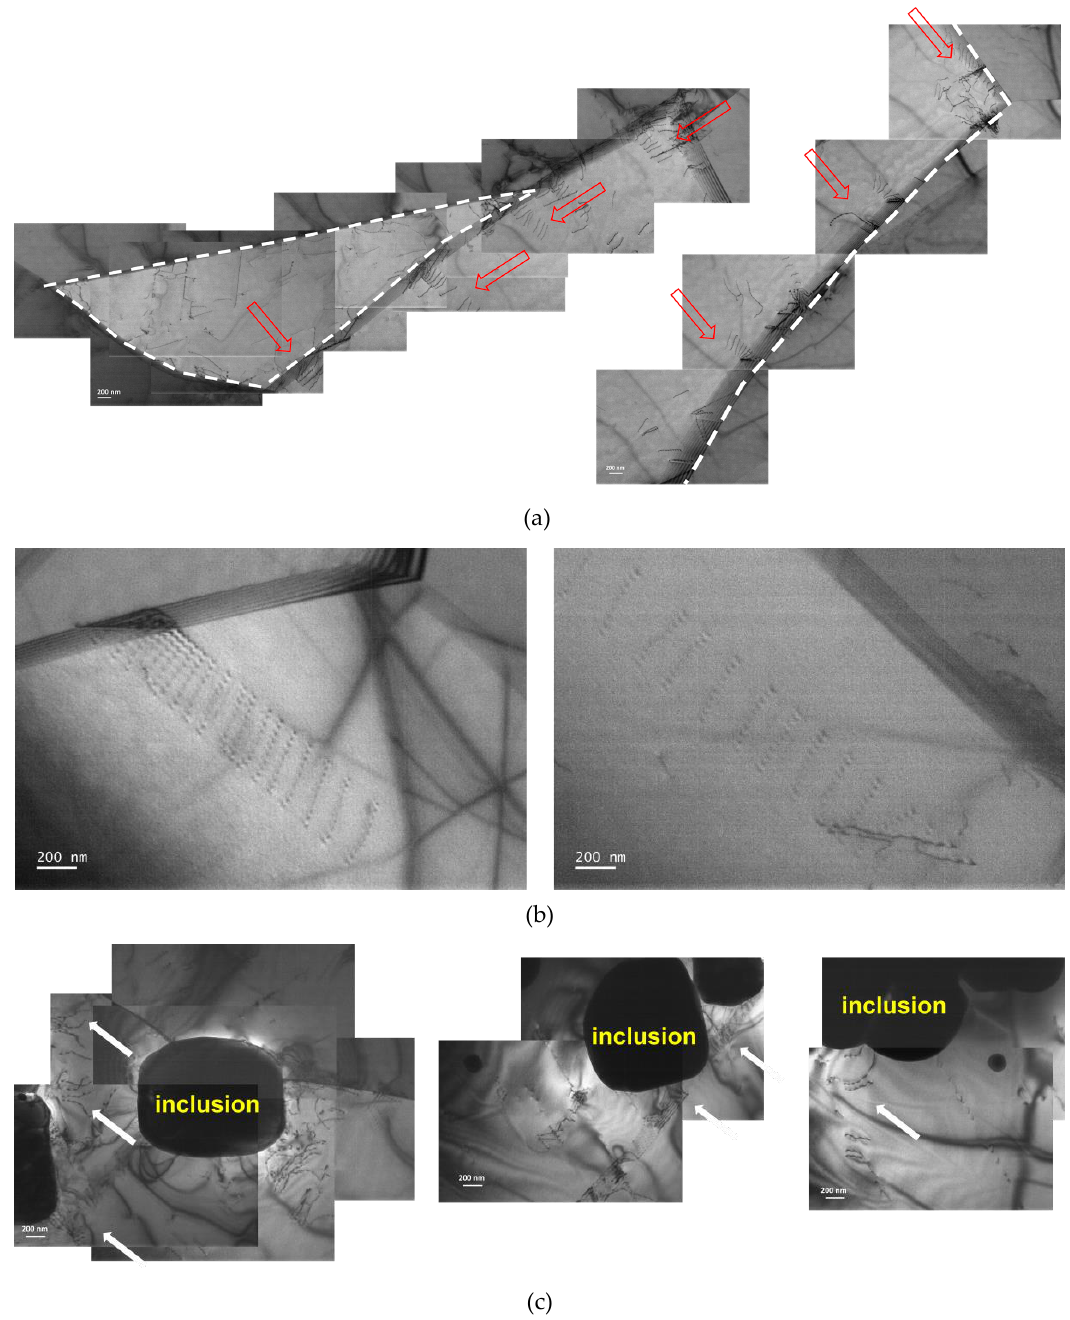
Figure 9. ( a ) TEM bright field (BF) images showing a high dislocation density near grain boundaries. ( b ) Magnified images showing a high dislocation density near grain boundaries. ( c ) TEM BF image showing dislocation tangling around inclusion particles.